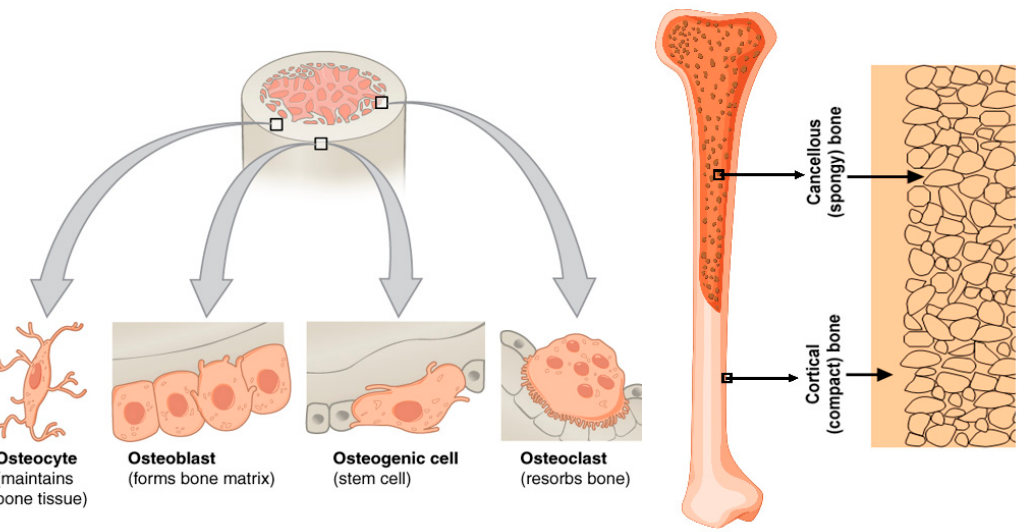
Figure 2. Human bone cells anatomy: bone has four cell types. Osteogenic cells become osteoblasts. Osteoblasts deposit matrix. Osteocytes form from osteoblasts trapped in calcified matrix. Different cell lineage osteoclasts resorb bone [17].